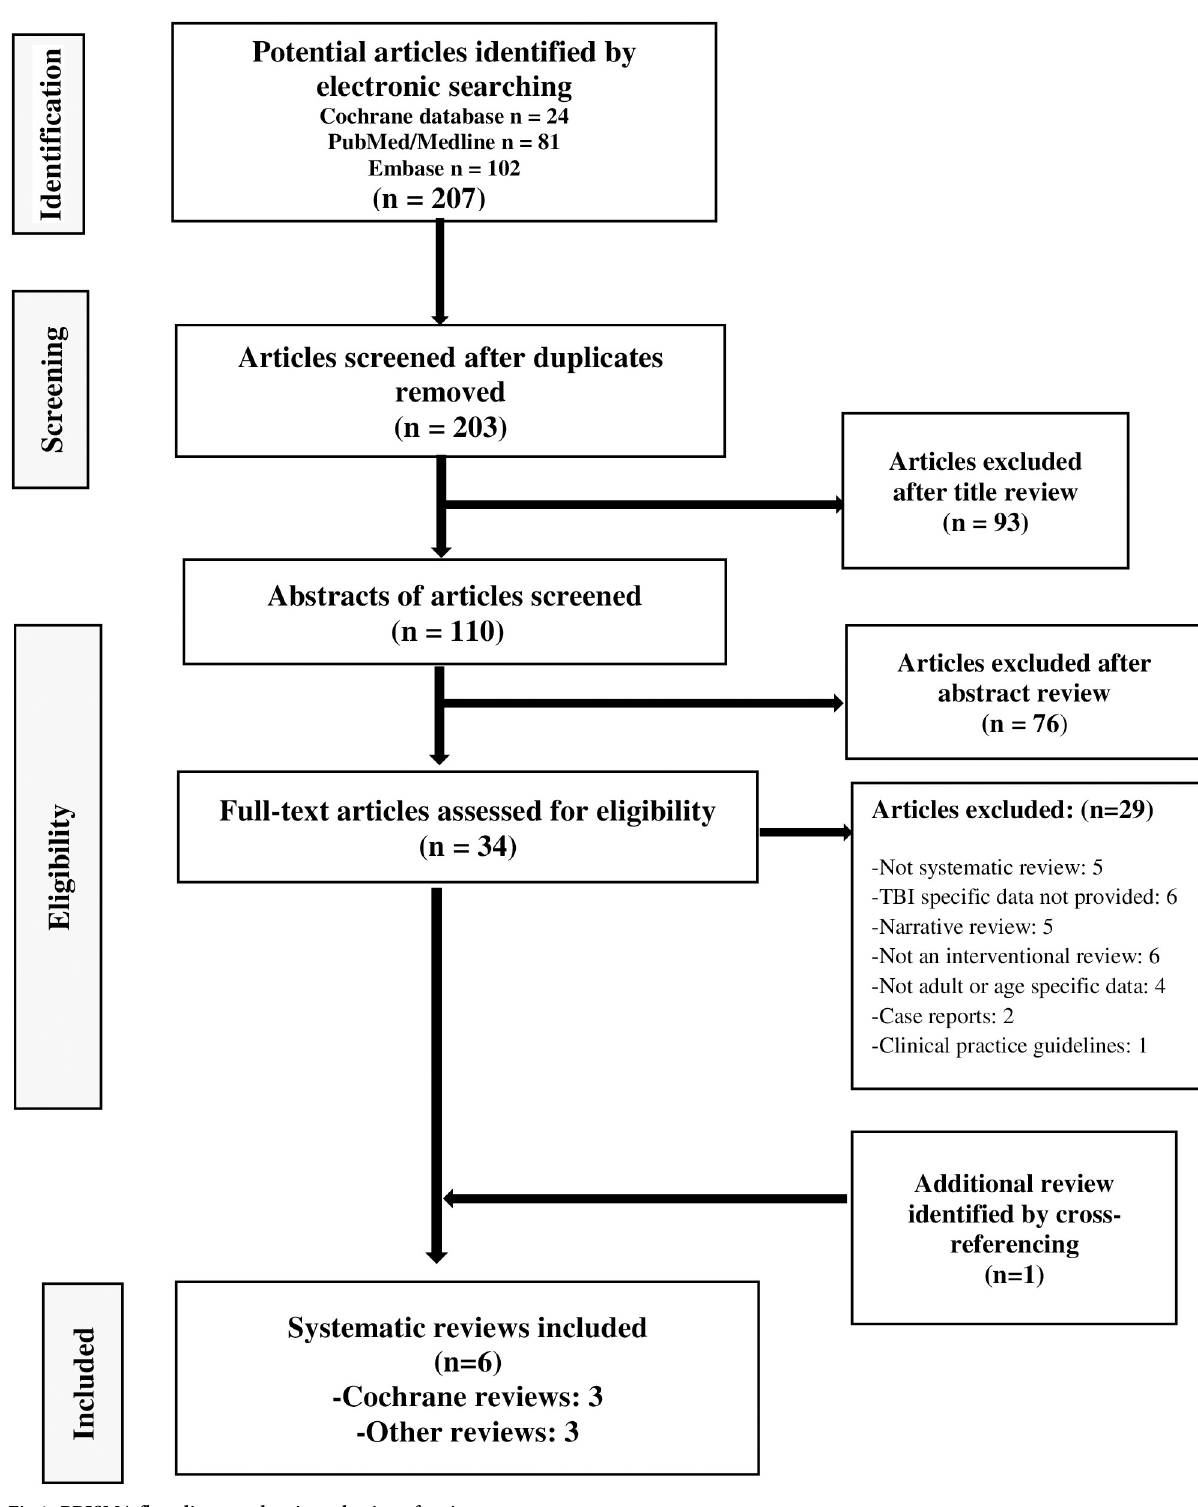
Fig 1. PRISMA flow diagram showing selection of reviews.